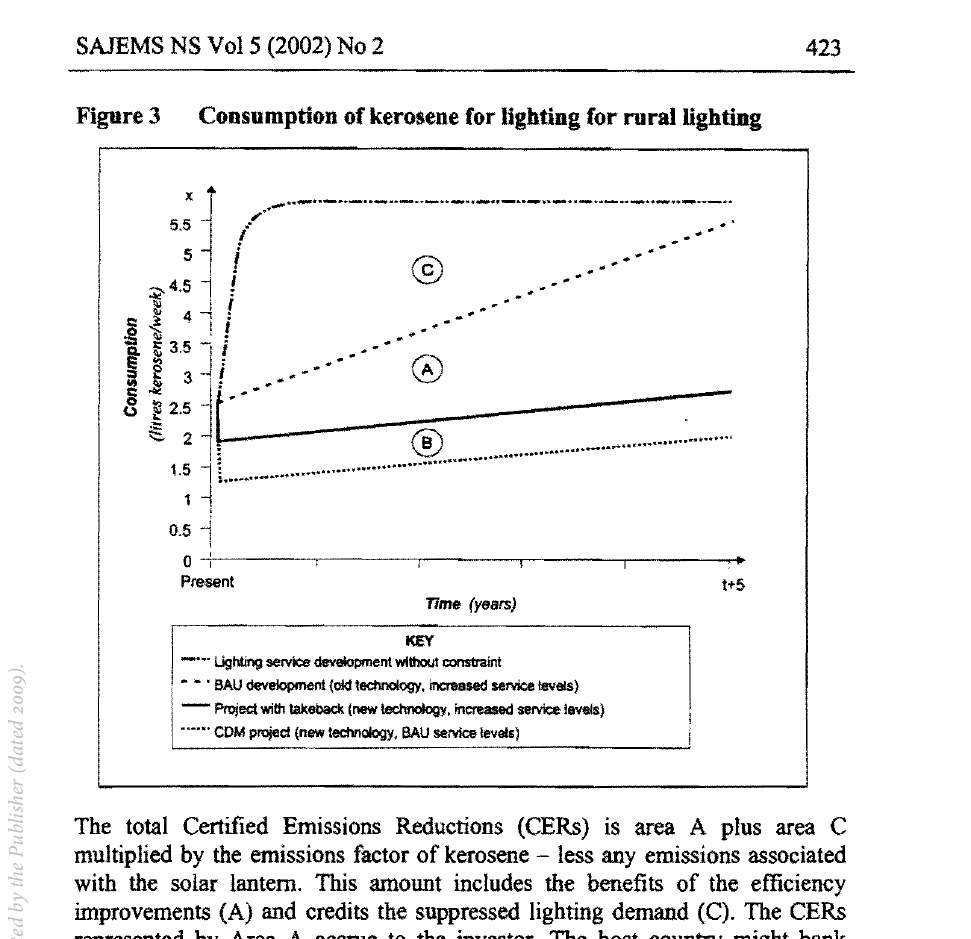
Figure 3 Consumption of kerosene for lighting for rural